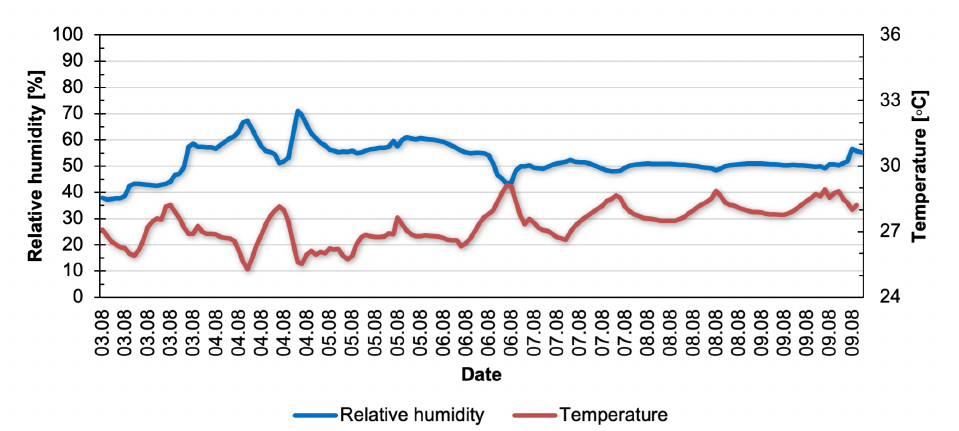
Figure 4. Measured values in the living room (temperature and relative humidity).